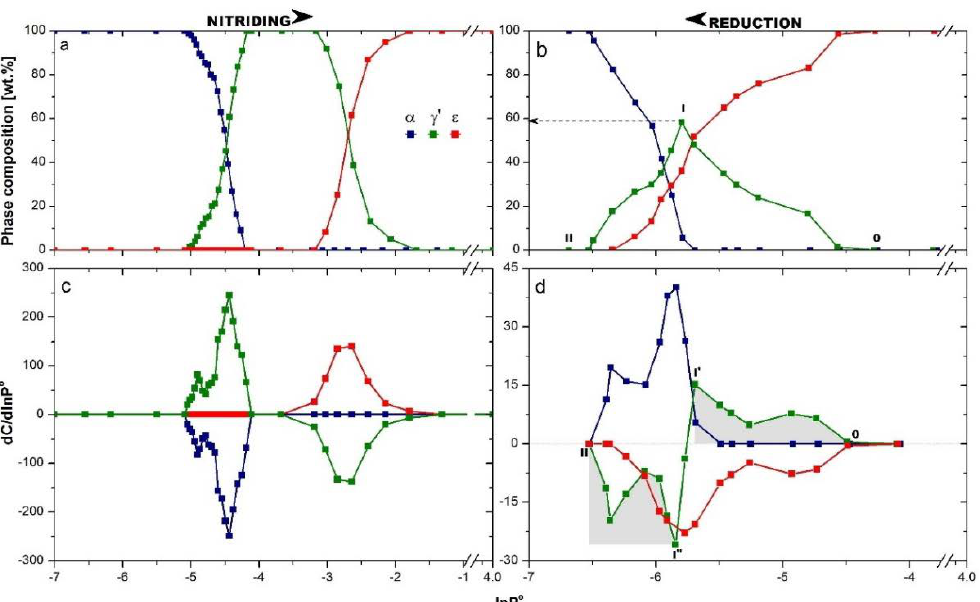
Figure 3. Sample phase composition during nitriding ( a ) and reduction ( b ) processes, and their changes of phase content on nitriding potential ( c , d ).